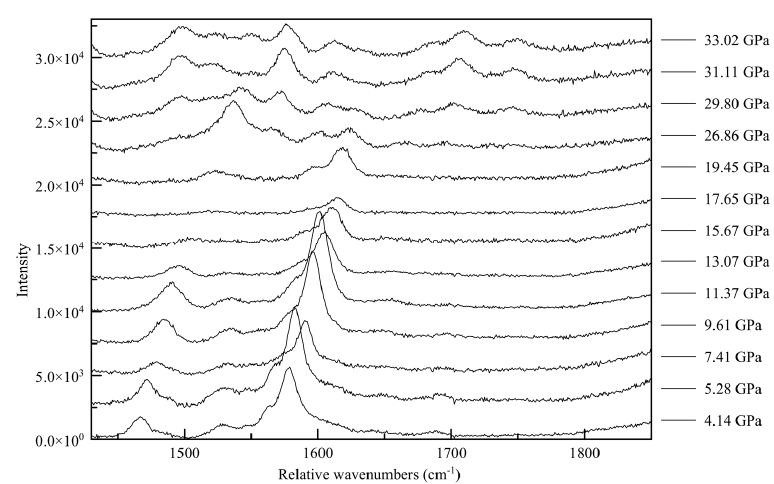
Figure 15. Raman spectra of melamine in the C-N vibration mode range, vertical offset indicates pressure steps in GPa. Appearance of new peaks at approximately 1700 and 17900 rel cm − 1 are seen above approximately 30 GPa.